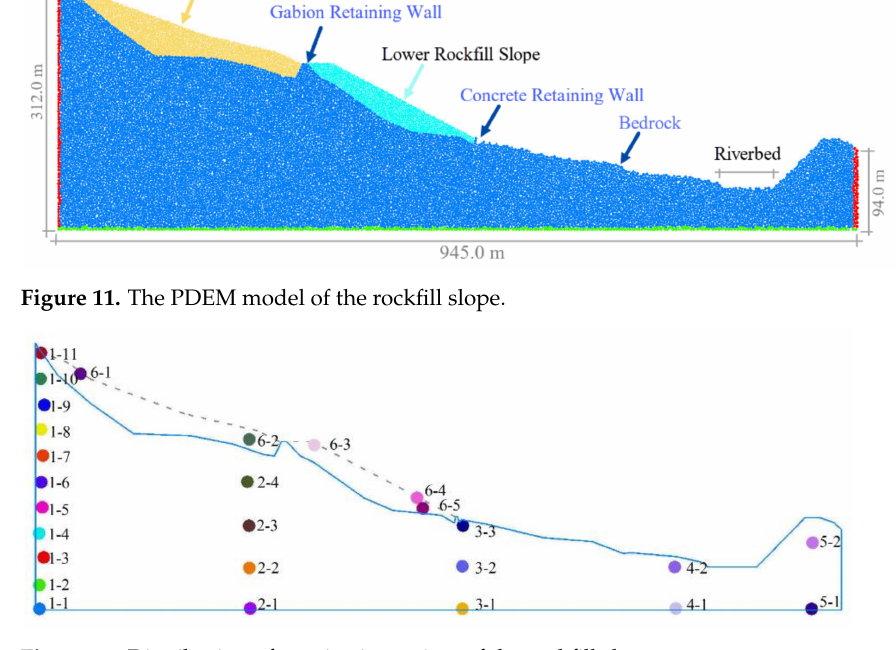
Figure 12. Distribution of monitoring points of the rockfill slope. The PDEM model size of the rockfill slope is 945 × 312 m (horizontal ×